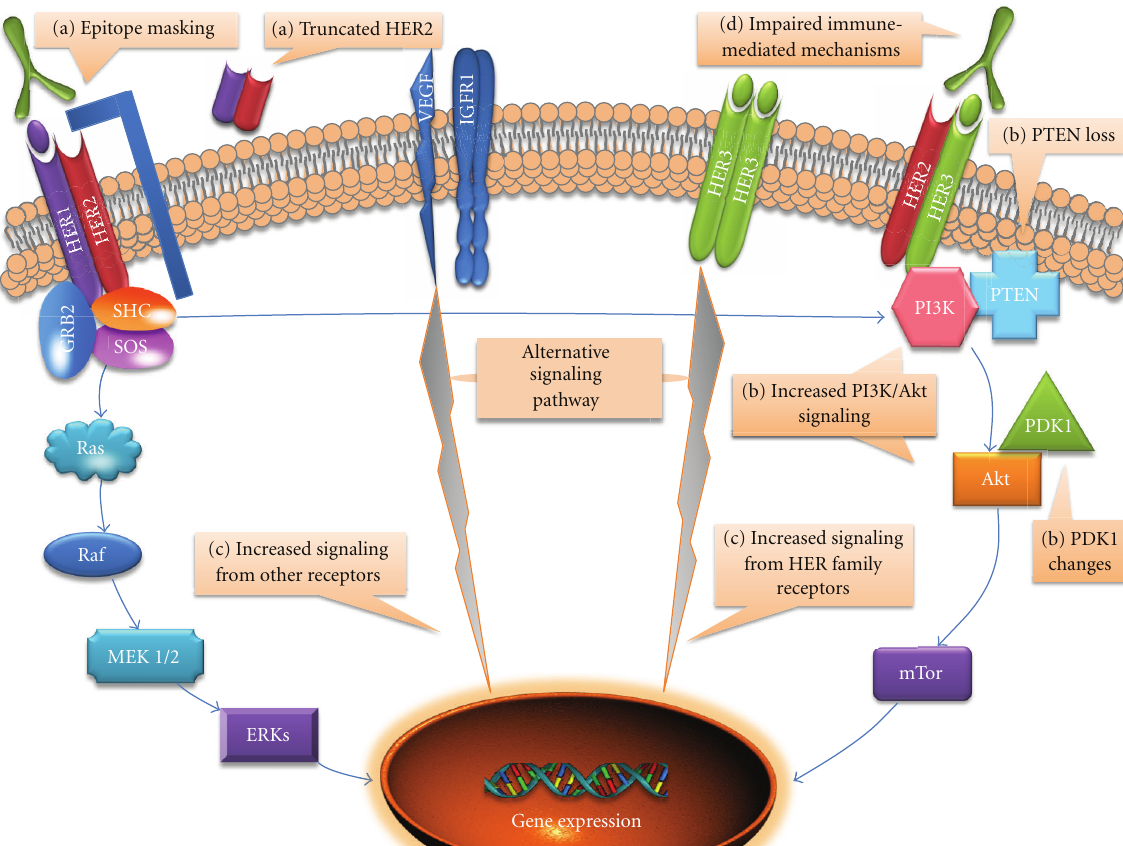
Figure 1: Relevant mechanisms of trastuzumab resistance in breast cancer: (a) Impaired trastuzumab binding to HER2: truncated HER2 and epitope masking. (b) Upregulation of HER2 downstream signaling pathways: PTEN loss, increased PI3K/Akt activity and PDK1 changes. (c) Alternative signaling pathways: Increased signaling from HER family and other receptors. (d) Impaired immune-mediated